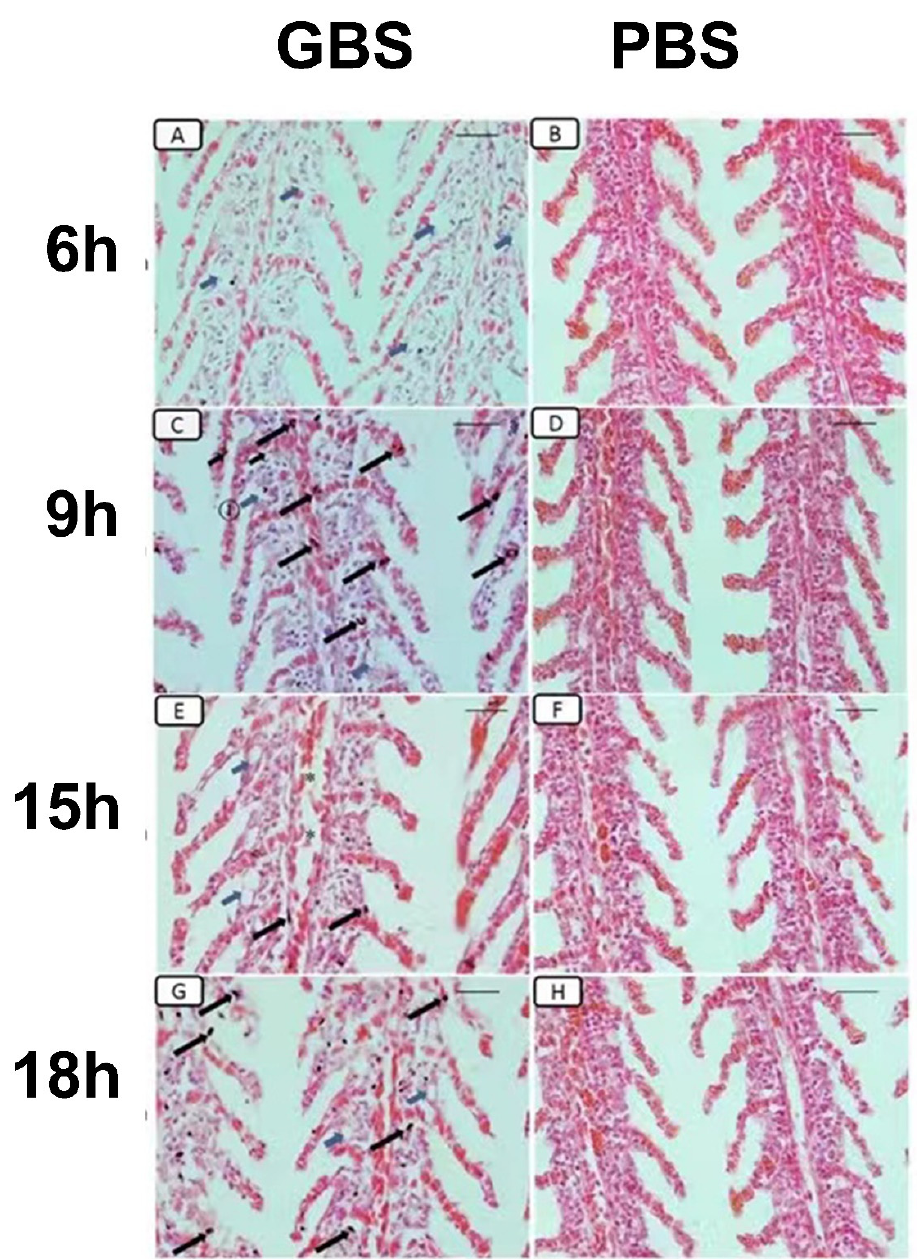
Figure 7. Pathologic examination of the gills of tilapia taken at 6 h, 9 h, 15 h, and 18 h post-challenge with GBS and PBS (hematoxylin-eosin staining, HE). ( A ) Severe oedema of mucous cells in the filament (blue arrow: ↑ ). ( C ) GBS dispersed in the filaments and lamellae (black arrow: ↑ ); infiltration of inflammatory cells present in areas of filament and lamellae’s vessel (long arrow); inflammation of mucous cells (blue arrow ① : ↑ ). ( E ) Severe oedema of mucous cells in the filament (blue arrow: ↑ ), lamellar telangiectasis (*), infiltration of lightly inflammatory cells (long arrow). ( G ) Numerous inflammatory cells were distributed in filaments and lamellae (long arrow). ( B , D , F , H ) were intraperitoneally injected with PBS and present a normal structure of the gills with no abnormalities in the tissue (×400, Scale bars = 25 μ m).